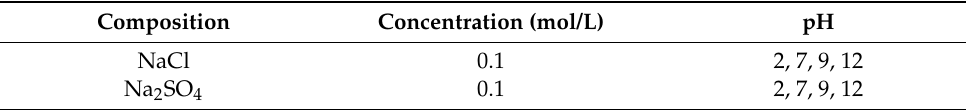
Figure 2. White sandstone specimens.